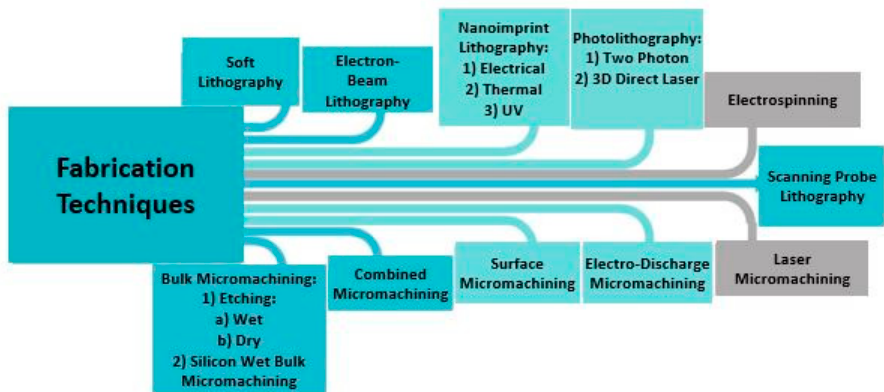
Figure 4. BioNEMS/MEMS fabrication